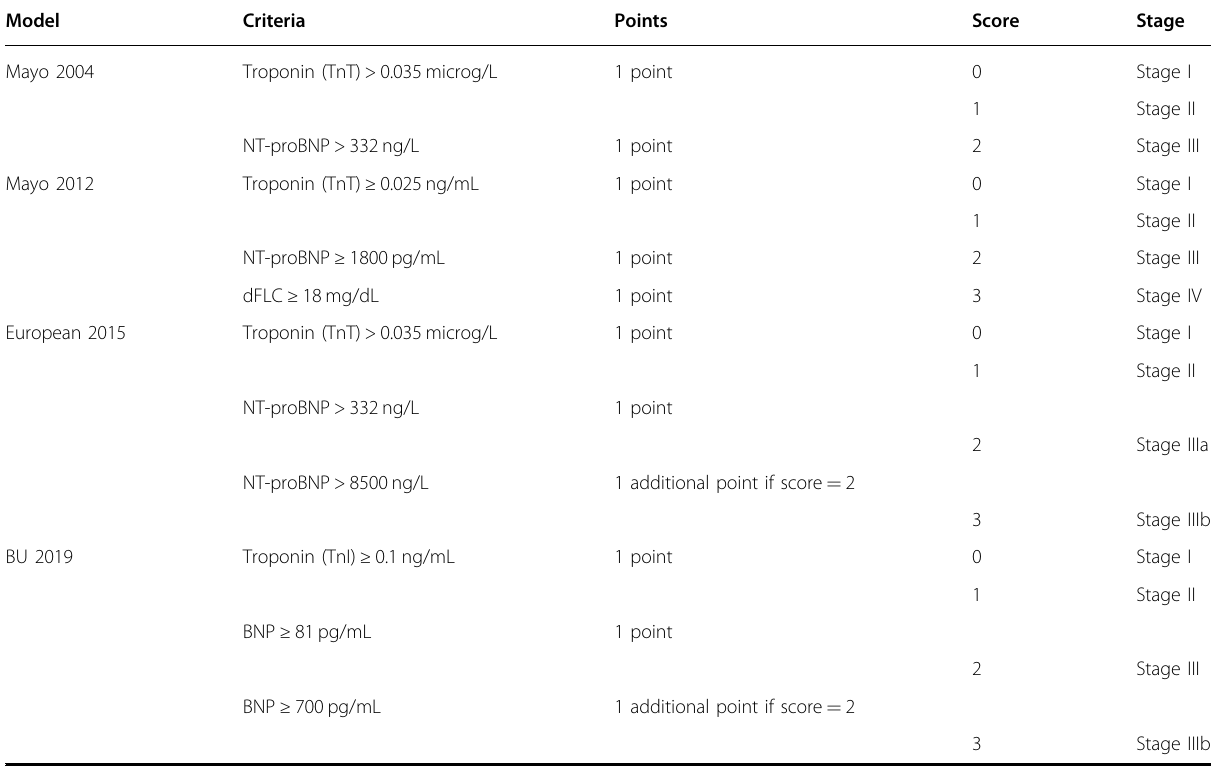
Table 1 Amyloidosis staging